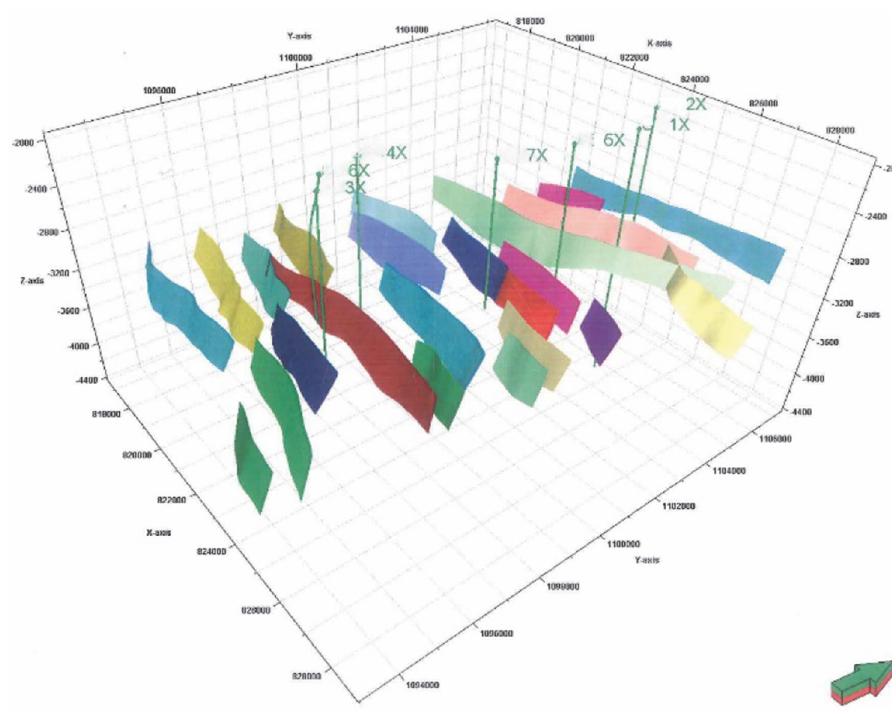
Fig. 9 Fault model of C-reser- voir X field